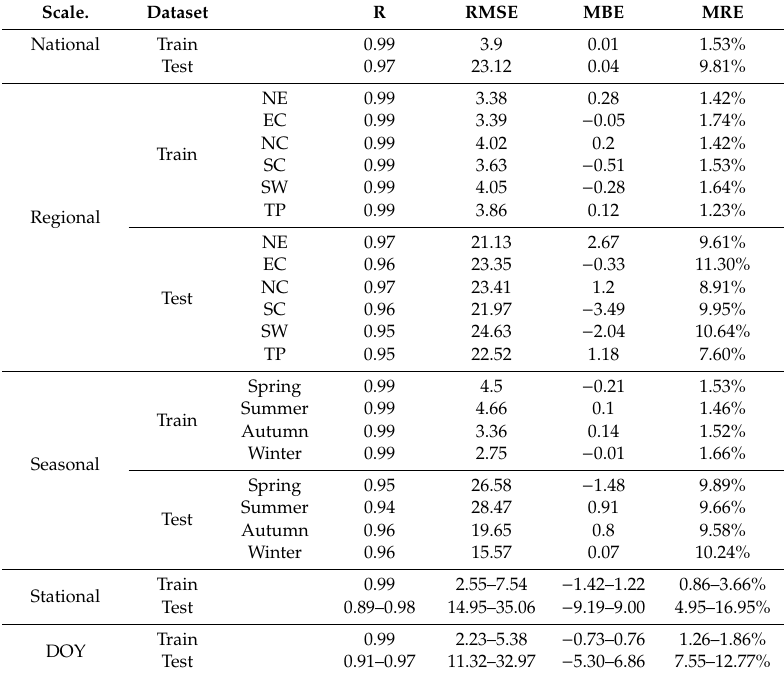
Table 1. Training and test results of the ERT-based